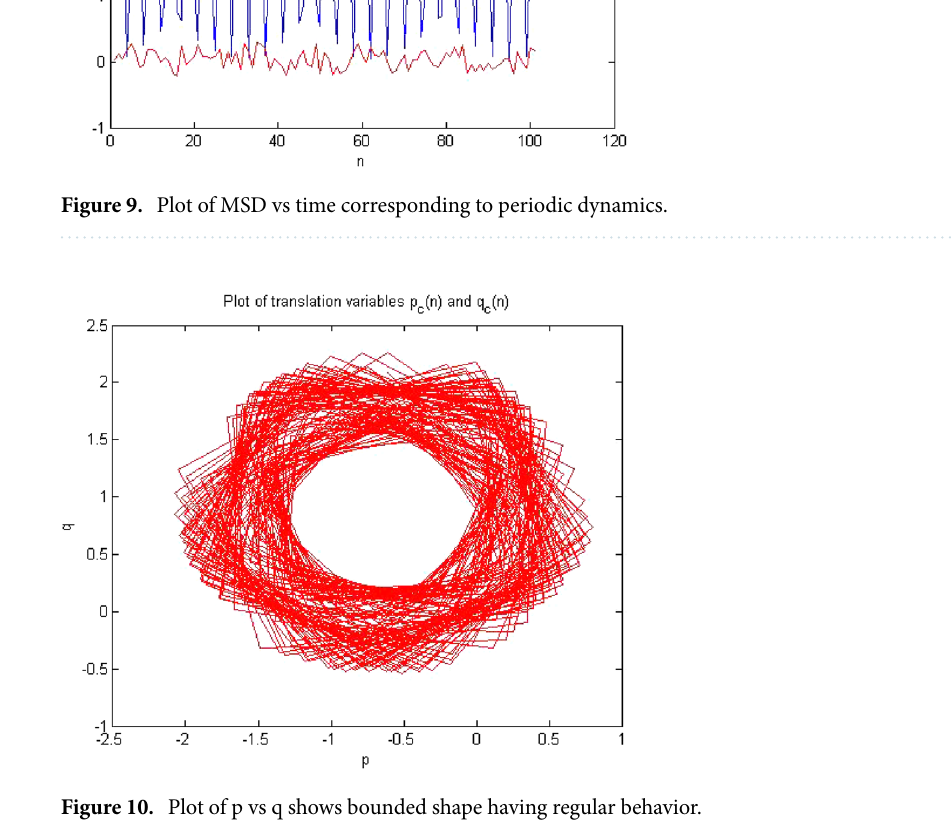
Figure 10. Plot of p vs q shows bounded shape having regular behavior.